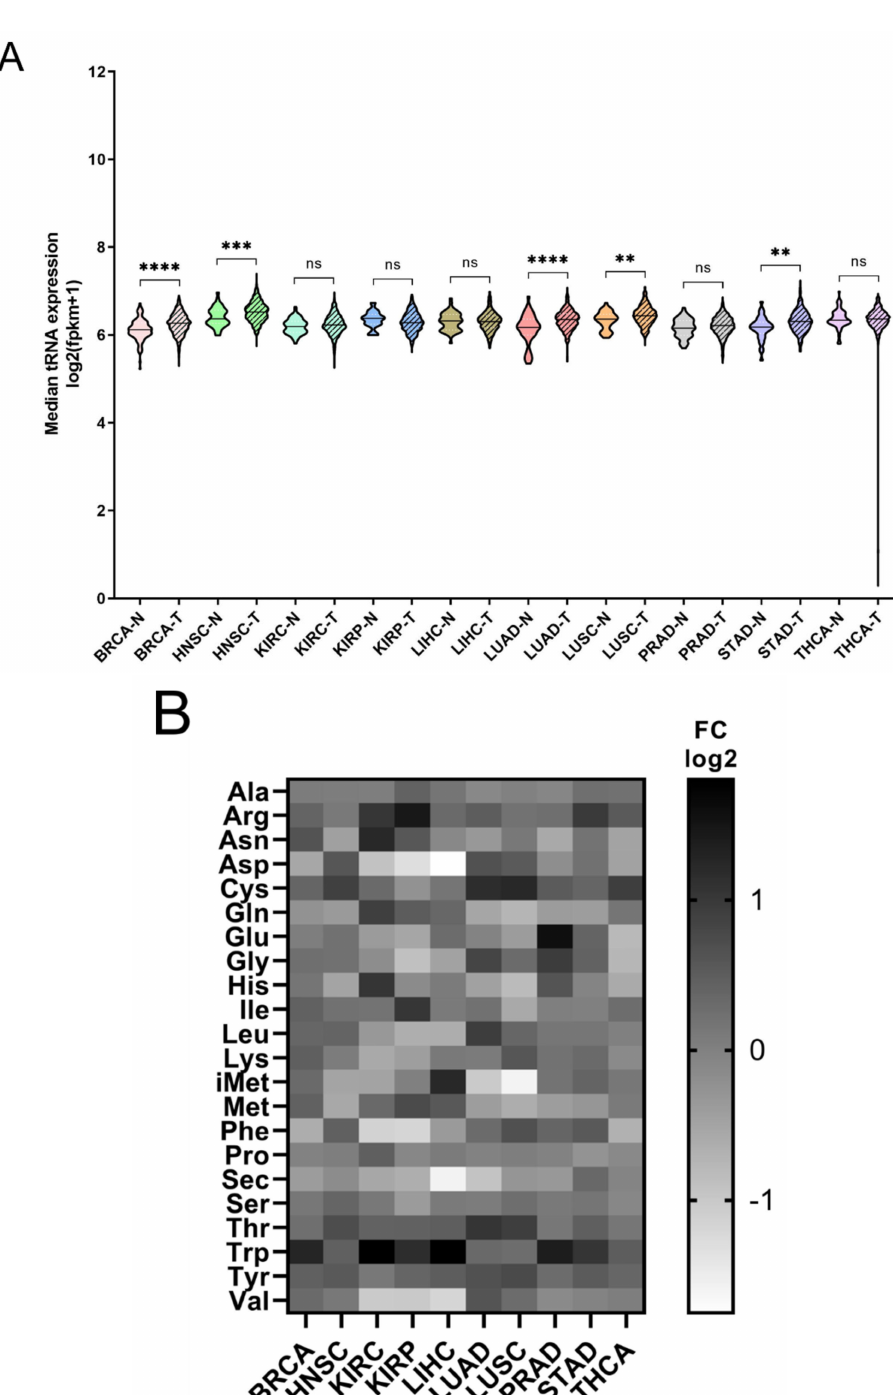
Figure 4. tRNA expression in normal and tumour tissues. ( A ) Median tRNA expression in normal (N) and tumour (T) tissues. The p -values were calculated using the Mann–Whitney test. **** p < 0.0001, *** p < 0.001, ** p < 0.01, ns: not significant. ( B ) Fold change (FC) of tRNA median expression in tumour vs. normal